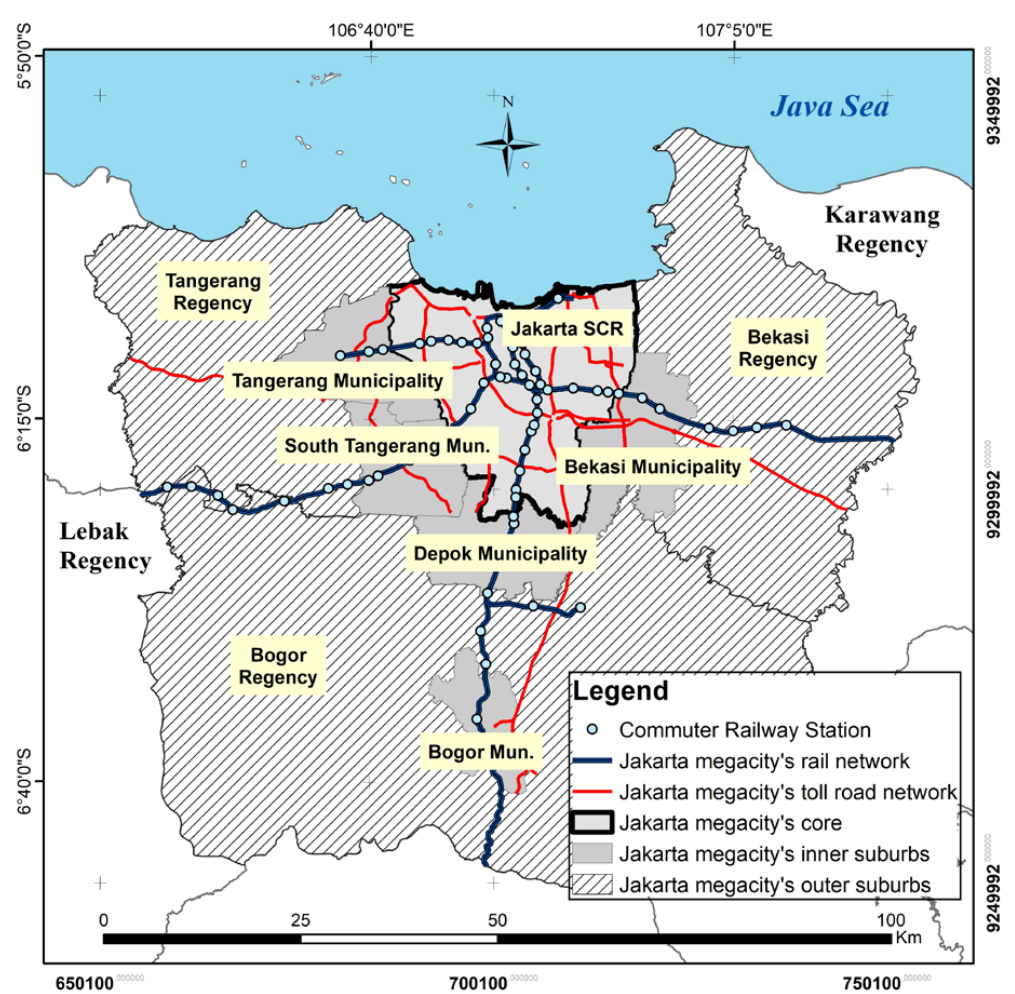
Figure 1. Jakarta megacity or Jakarta Metropolitan